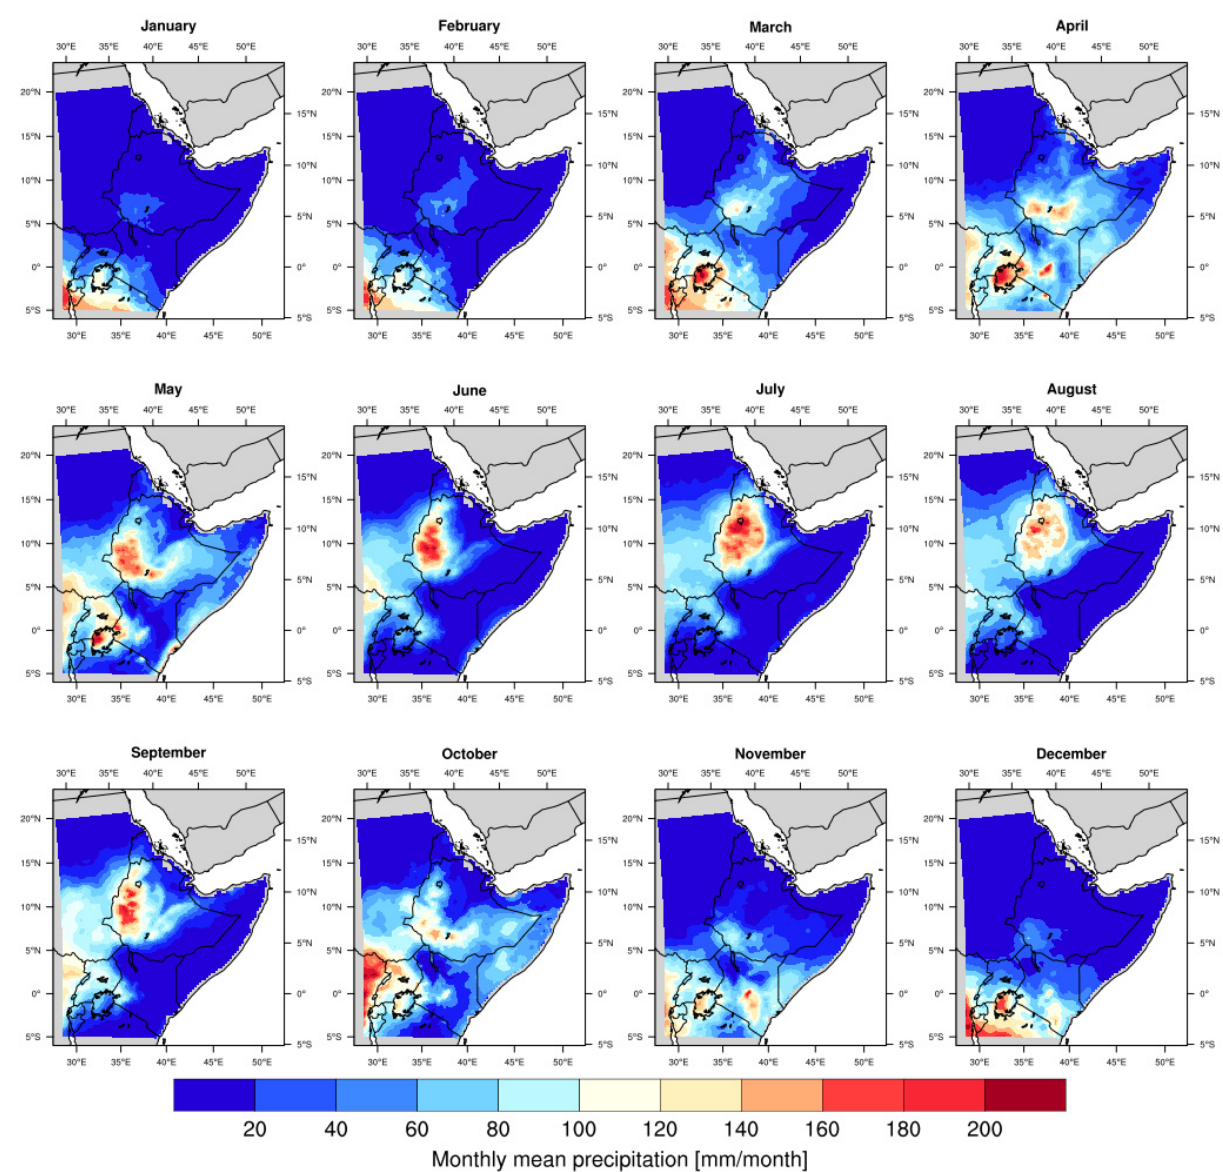
Figure 2. EA monthly mean precipitation relative to the period 1983–2017. Monthly climatology has been obtained from the ensemble mean of the three precipitation products.